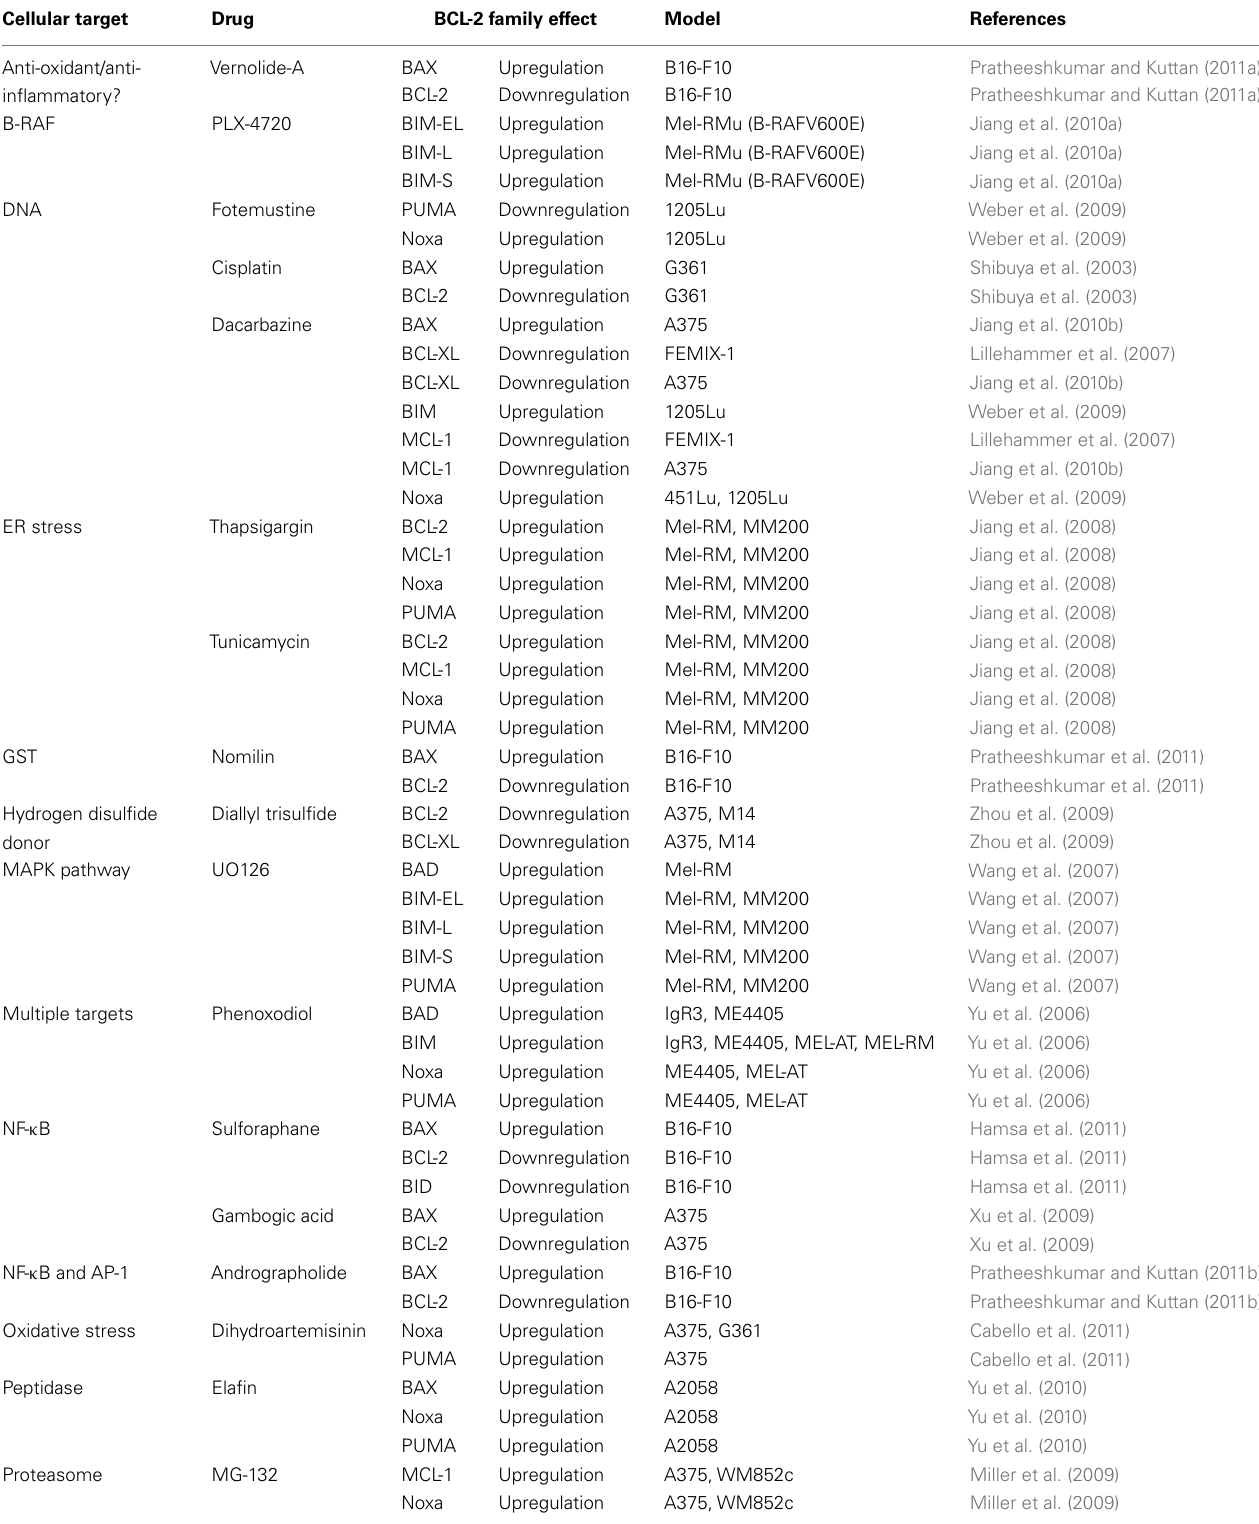
Table 1 |A list of chemotherapeutics that induce changes to the BCL-2 family in various melanoma cell lines. Cellular